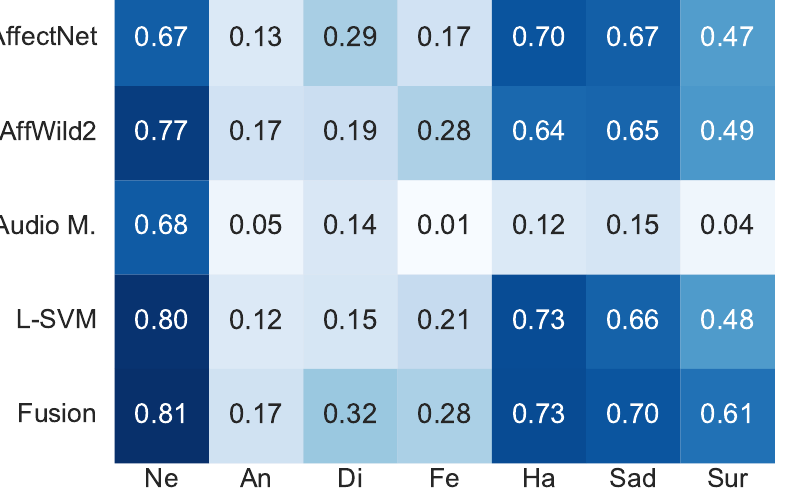
Figure 6. Classwise F1-scores for the proposed unimodal models and their fusion. Ne—Neutral, An—Anger, Di—Disgust, Fe—Fear, Ha—Happiness, Sad—Sadness, Sur—Surprised.